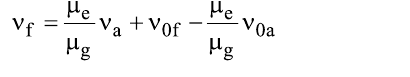
Figure 3: Solvatochromic plot of the absorption ( ν a ) and fluorescence ( ν f ) maxima of NR in a series of solvents at 25 °C (a) against the Lippert solvent polarity function f ( ε ) − f ( n 2 ), (b) against absorption maximum ν a and (c) against the fluorescence maximum ( ν fs ) of the intramolecular charge-transfer band of 4-(diisopropylamino)benzo- nitrile (DIABN). In panel (a) the data for ν a and ν f are shown with blue squares and red circles, respectively. From the slopes of the straight lines fitted through the filled circles and squares according to Equation 1 and Equation 2 in (a), Equation 4 in (b) and Equation 10 in (c) the ground ( μ g ) and excited state dipole moments ( μ e ) of NR are calculated, see Table 2. The solvents are indicated by the numbers in the first column of Table 1.